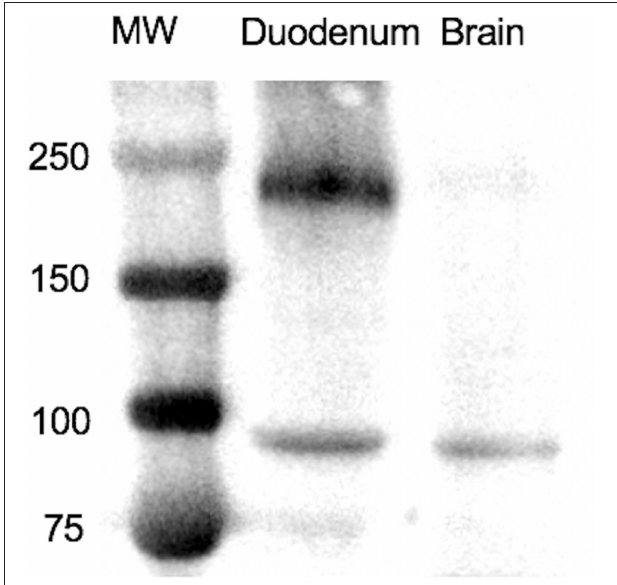
FIGURE 1 | On Western blotting a protein of ∼ 240 kD was recognized in a tissue lysate of duodenum. MW, molecular weight in